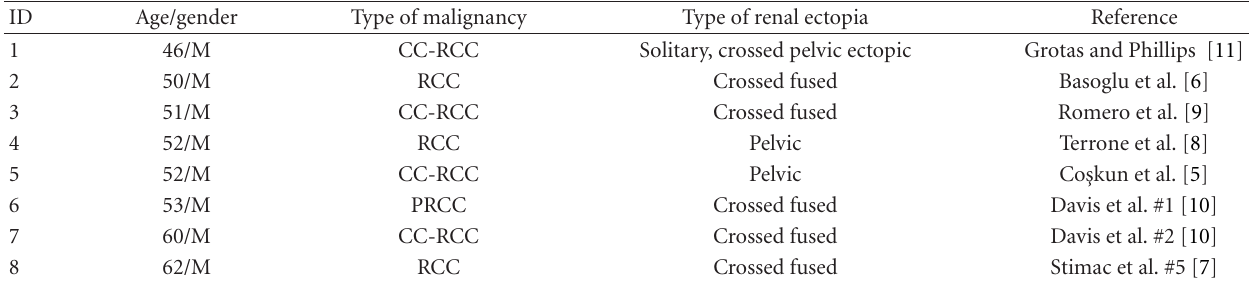
Table 1: Eight cases of renal parenchymal malignancies in ectopic